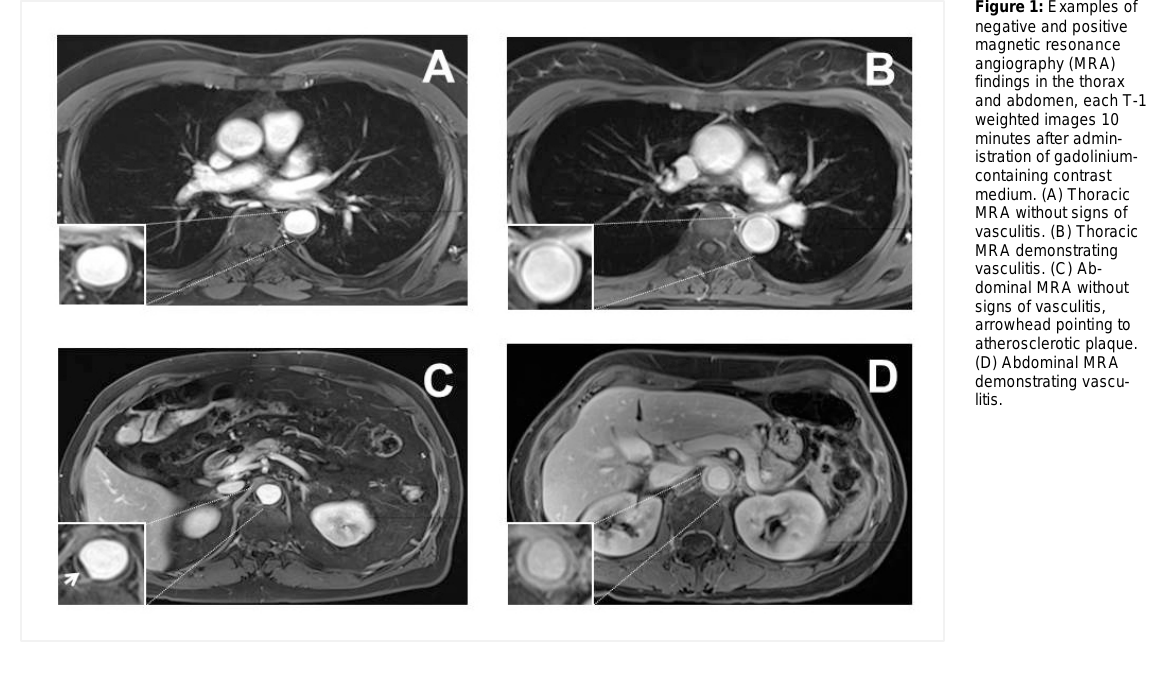
Figure 1: Examples of negative and positive magnetic resonance angiography (MRA) findings in the thorax and abdomen, each T-1 weighted images 10 minutes after admin- istration of gadolinium- containing contrast medium. (A) Thoracic MRA without signs of vasculitis. (B) Thoracic MRA demonstrating vasculitis. (C) Ab- dominal MRA without signs of vasculitis, arrowhead pointing to atherosclerotic plaque. (D) Abdominal MRA demonstrating vascu-